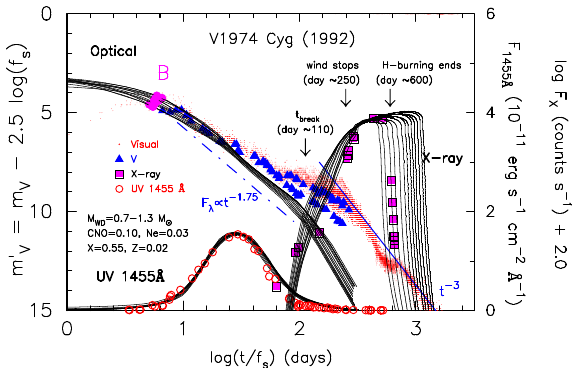
Figure 3: Free-free emission model light curves for various WD masses from 0 . 7 M (cid:12) to 1 . 3 M (cid:12) by steps of 0 . 05 M (cid:12) (taken from Hachisu & Kato 2010 ). The time scales are squeezed or stretched by a factor of f s along time to fit each other and the magnitude is shifted by − 2 . 5 log f s . The two straight lines indicate the decline rates of free-free flux, i.e., F ν ∝ t − 1 . 75 (dash-dotted line) and F ν ∝ t − 3 (solid line). Observational data of V1974 Cyg are superposed.